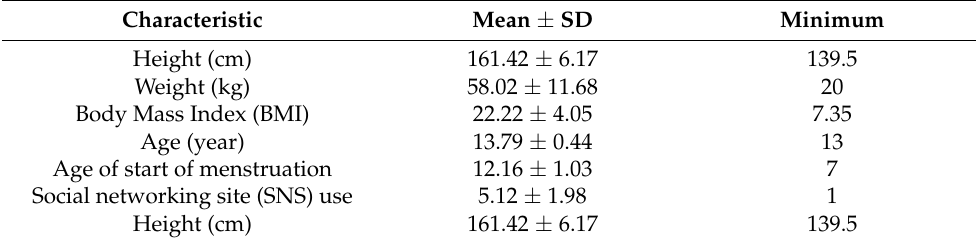
Table 1. Descriptive statistics (Operational n = 4734).